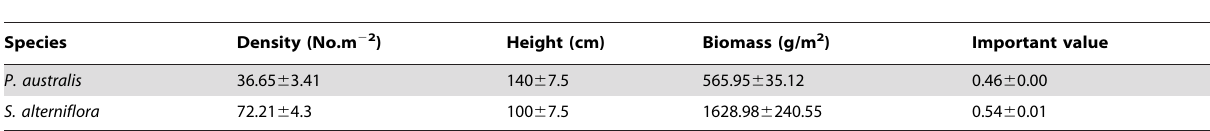
Table 1. Population characteristics in the study area (n=50 plots) (mean 6 SE).